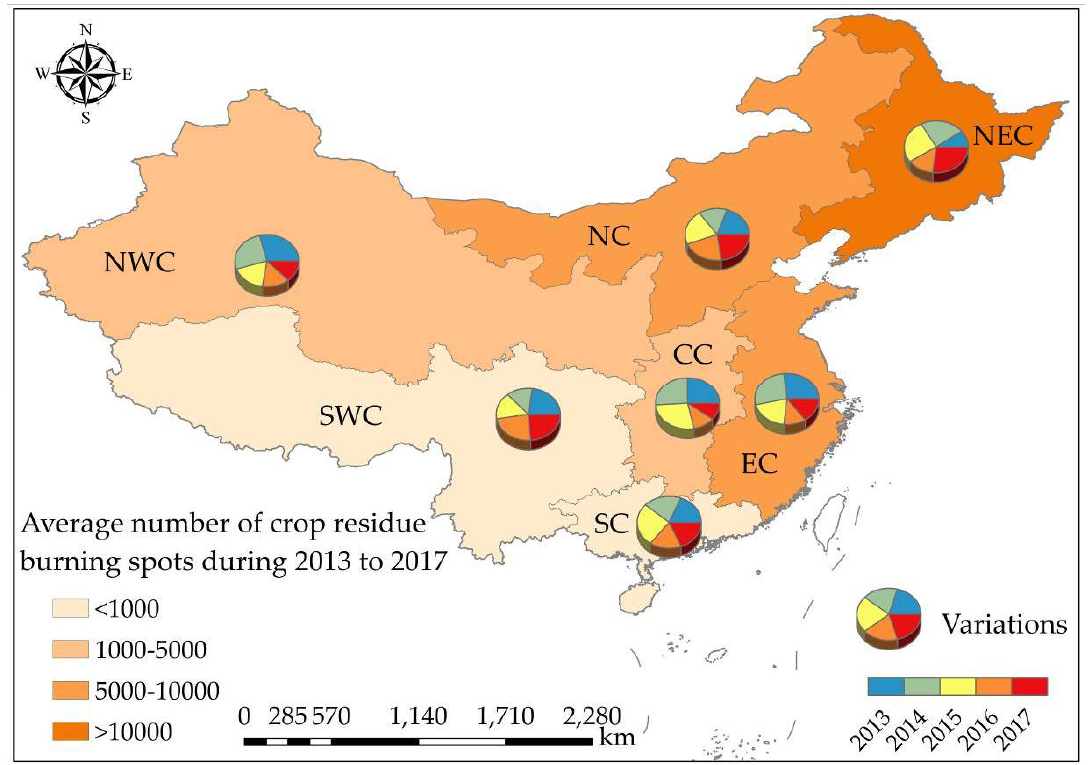
Figure 8. Interannual variations of crop residue burning spots in different regions of study area.